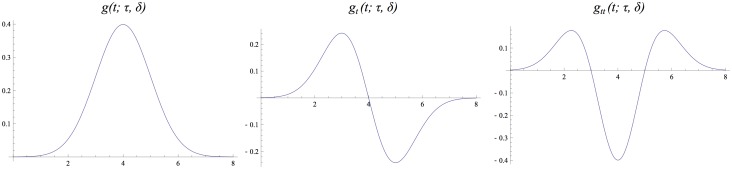

The time-shifted Gaussian kernel
g(t;τ,δ)=1/2πτexp(−(t−δ)2/2τ) for τ = 1 and δ = 4 with its first- and second-order temporal derivatives.